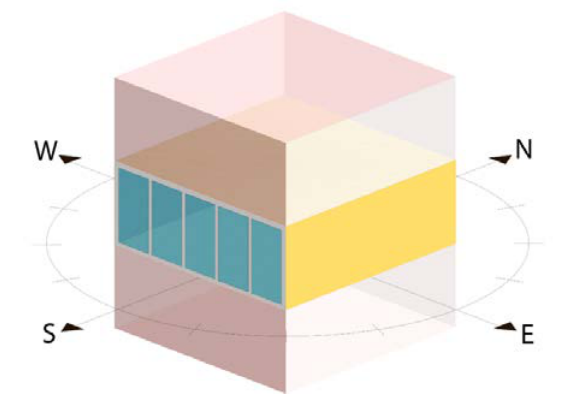
Fig. 2 Geometry of the thermal and ecological simulation